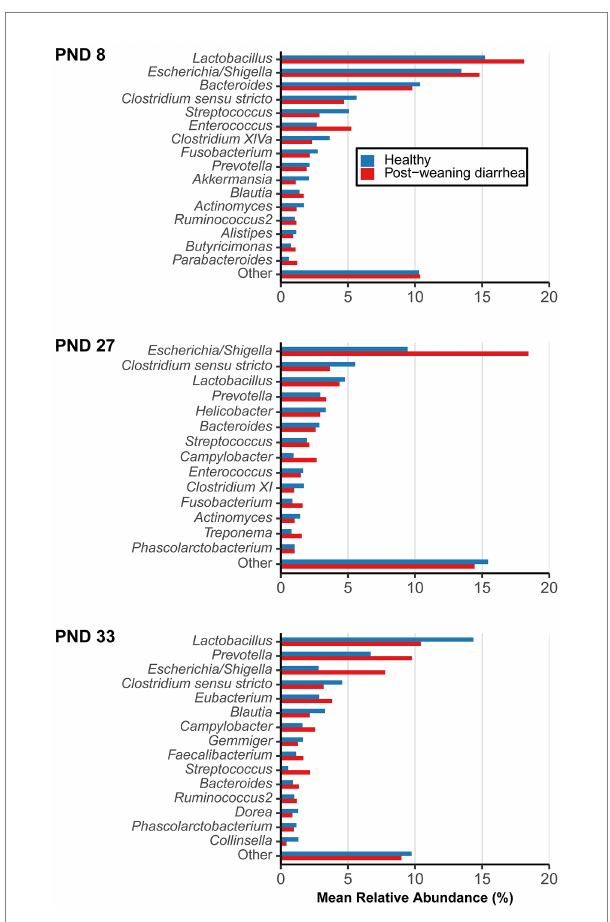
FIGURE 3 Mean relative abundance of most abundant genera, grouped by post-weaning diarrhea (PWD) status. Samples were collected longitudinally and the groups were compared at post-natal day (PND) 8 (early lactation, healthy: n = 20 pigs, PWD: n = 24 pigs), at PND 27 (late lactation, healthy: n = 20 pigs, PWD: n = 23 pigs), and PND 33 (7 days after weaning, healthy: n = 18 pigs, PWD: n = 25 pigs) which was the time of active PWD where pigs were divided into PWD cases and healthy controls for comparison. Genera representing <1% mean relative abundance were pooled into “Other.” Accumulated mean relative abundance of unassigned taxa (not shown) at genus level represented 20.00% (healthy) and 19.24% (PWD) at PND 8, 45.21% (healthy) and 37.62% (PWD) at PND 27, and 45.03% (healthy) and 41.36% (PWD) at PND